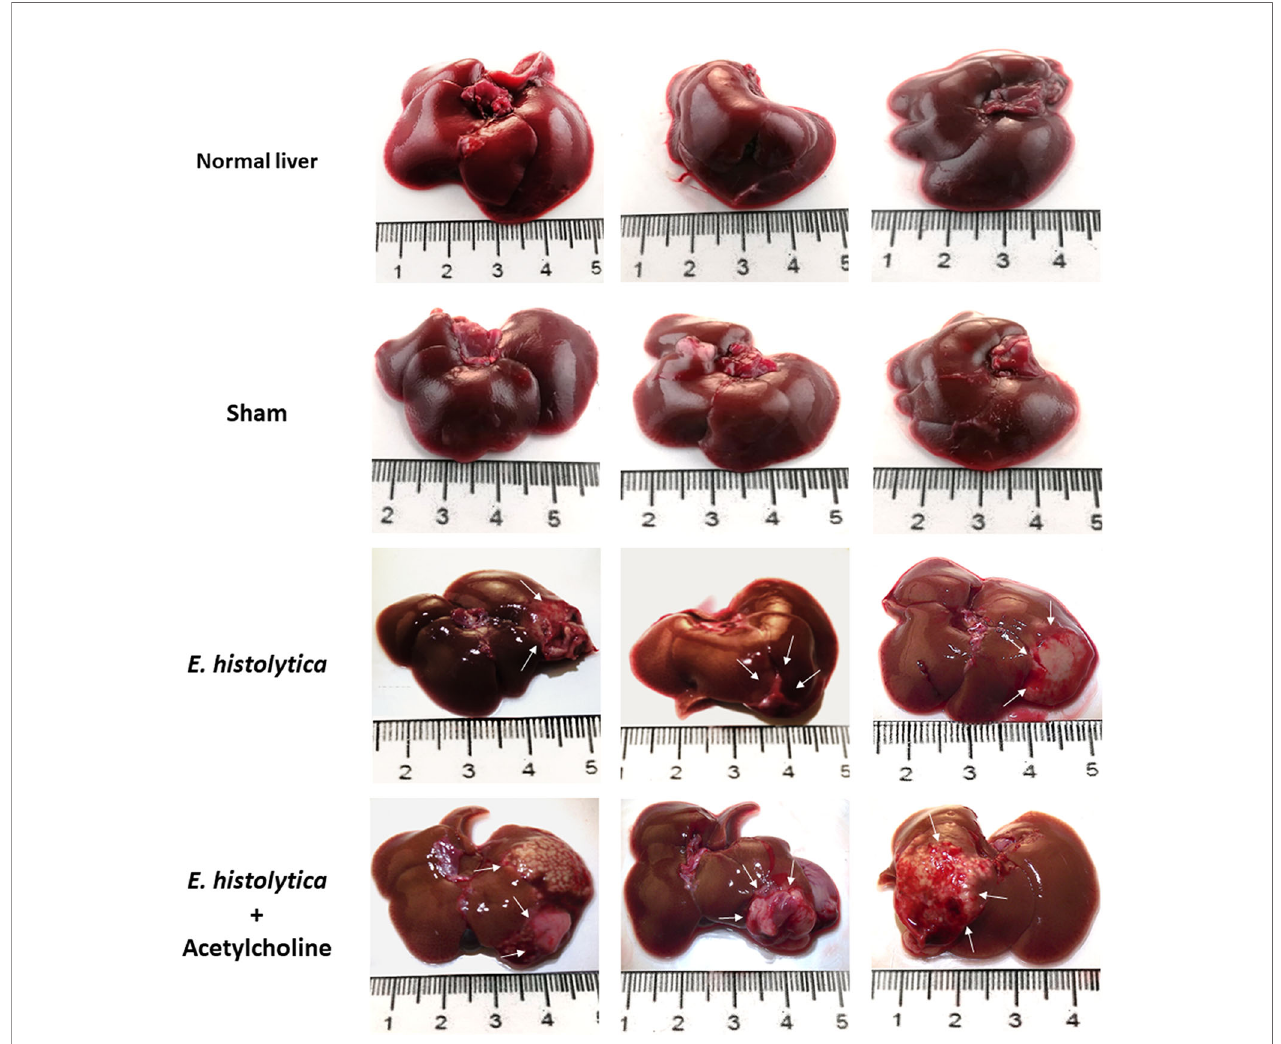
FIGURE 10 | Acetylcholine effects on the development of amebic liver abscesses (ALA). Trophozoites (7.5 × 10 5 ) were treated with 0.0001 µM ACh for 1 h and inoculated in hamsters. Representative images of ALA after 4 days of inoculation were taken to show macroscopic damage in male hamsters. Normal liver, control from non-infected hamsters. Sham (inoculated with SFM) and damage produced by ACh-untreated E. histolytica trophozoites. Arrows show single lesions by E. histolytica , as well as granulomas caused by trophozoites pre-treated with 0.0001 µM